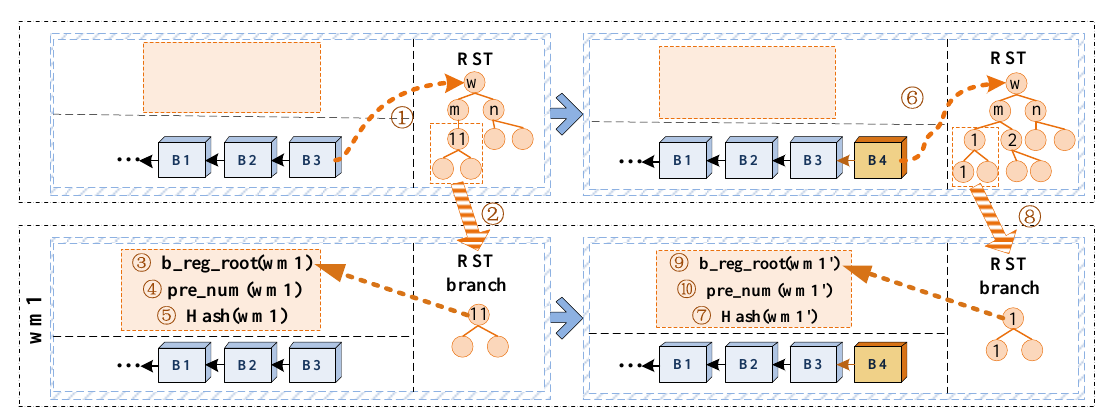
Figure 5. Schematic diagram of branch query method.